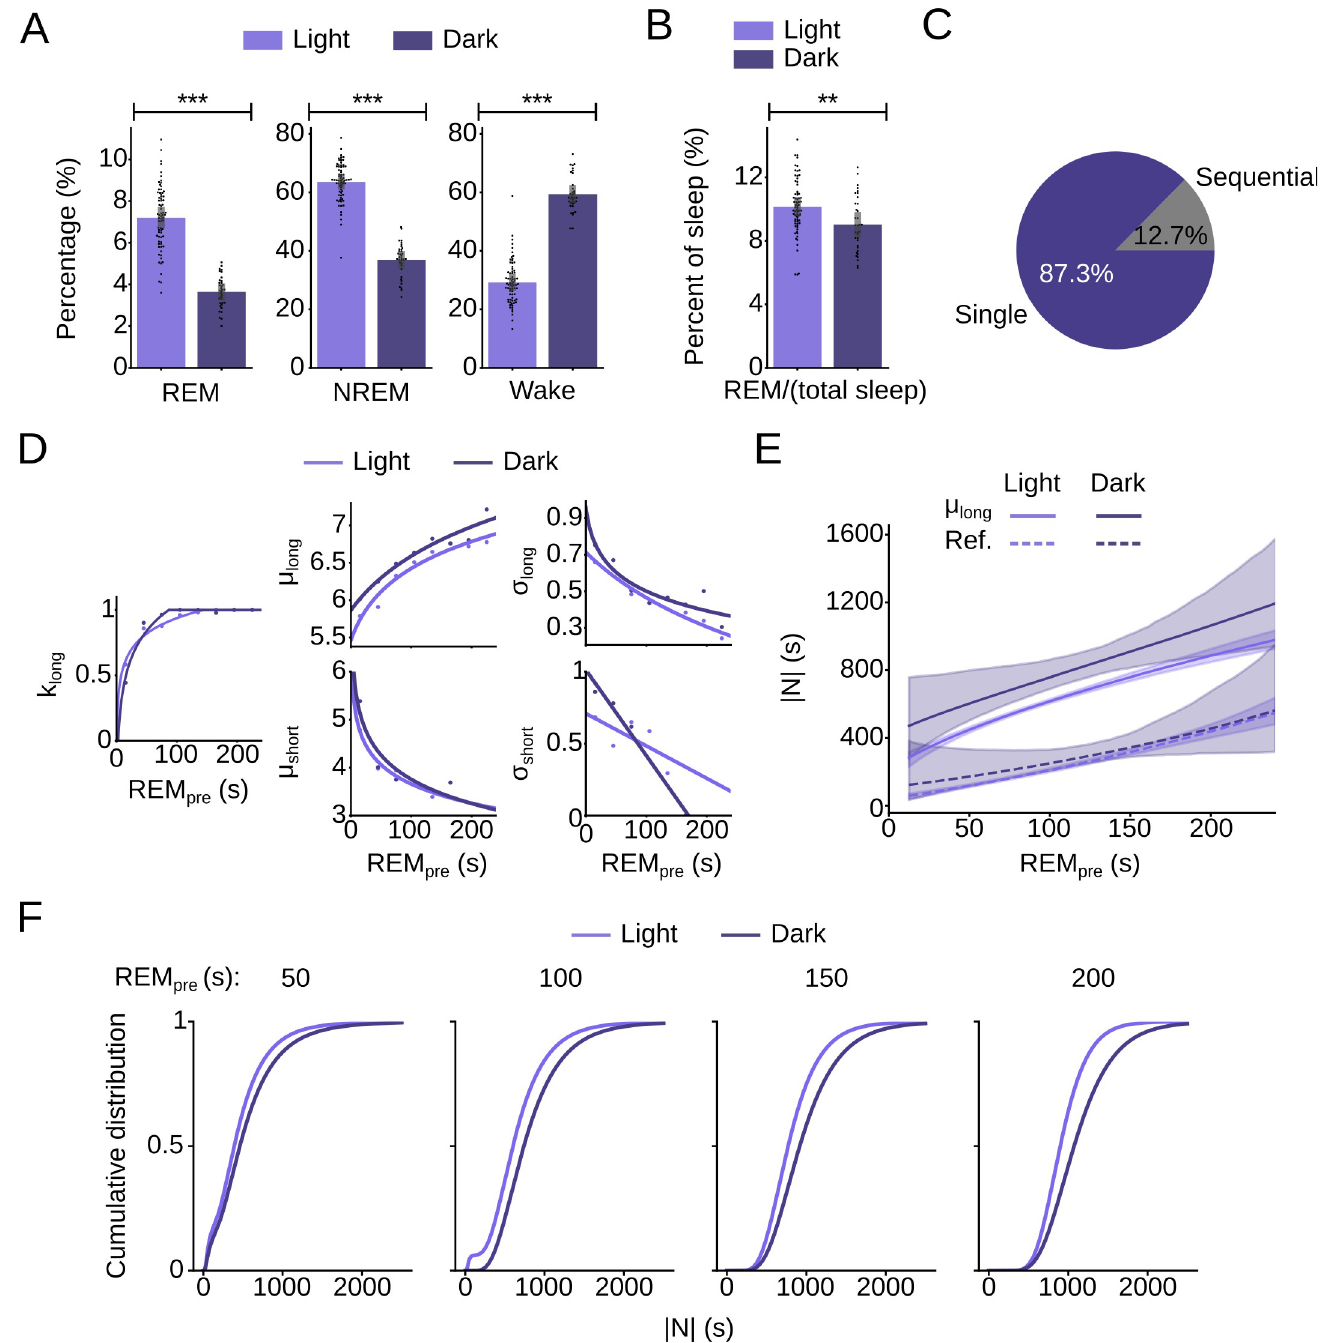
Fig 7. Changes in REM sleep regulation between light and dark phase. (A) Bar plots comparing the percentage of REM, NREM sleep, and wake during the light and dark phase (REM: Welch’s t-test, t = 16.14, p = 3.37e-30; NREM: t-test, t = 20.26, p = 4.53e-38; Wake: t-test, t = -20.79, p = 5.19e-39; n light = 72, n dark = 35 mice). Error bars, 95% CIs from 1,000 bootstrap iterations. (B) Bar plot comparing the ratio REM/(REM+NREM) for the light and dark phase (t-test, t = 3.17, p = 0.0019, n light = 72, n dark = 35 mice). Error bars, 95% CIs from 1,000 bootstrap iterations. (C) Pie chart showing the percentage of sequential and single cycles during the dark phase. (D) Comparison of GMM parameters for the light and dark phase (Welch’s t-test with Bootstrap, k long : t = -77.26, p = 0.0; μ long : t = -372.77, p = 0.0; σ long : t = -57.93, p = 0.0; Methods ). (E) Comparison of μ long (solid lines), and threshold (Ref., dashed lines) separating the refractory from the permissive period for the light and dark phase. Shadings, 95% CIs obtained from 10,000 bootstrap iterations. (F) Comparison of the CDFs of the GMMs for the light and dark phase shown for 4 different values of REM pre